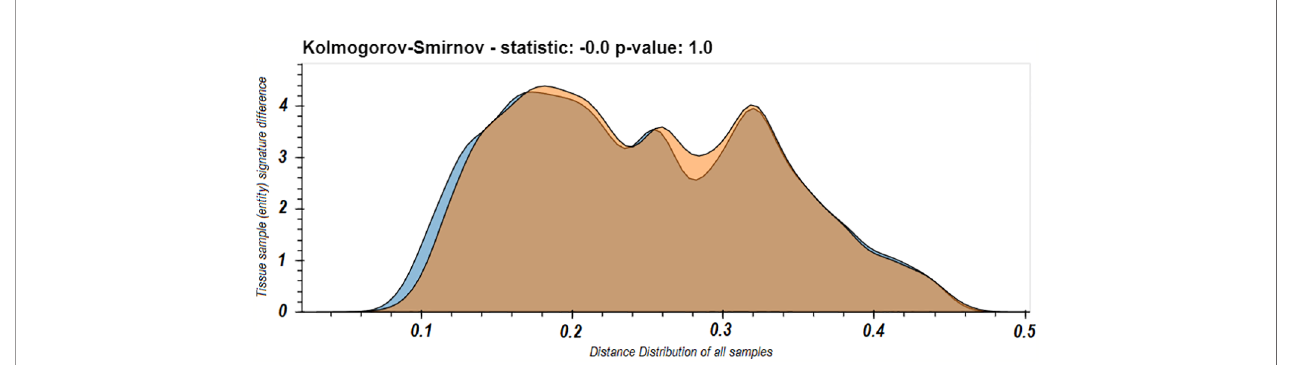
FIGURE 5 | Distribution of all between sample entity signature differences in the immune domain for D207 with or without the spleen samples. The distribution of between sample signature differences comparing all samples in D207 (blue) and when all the samples in spleen are removed from the calculation of the immune domain (orange). In both cases the distances from samples in the spleen are not